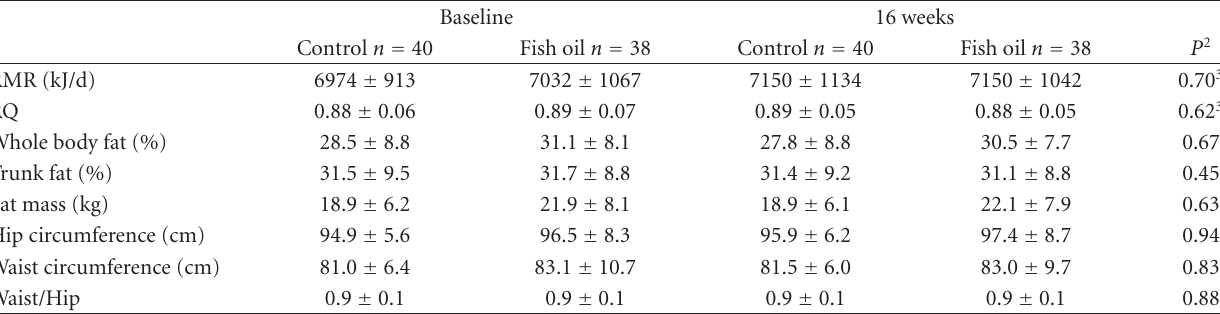
Table 2: Metabolic rate and body composition 1 .